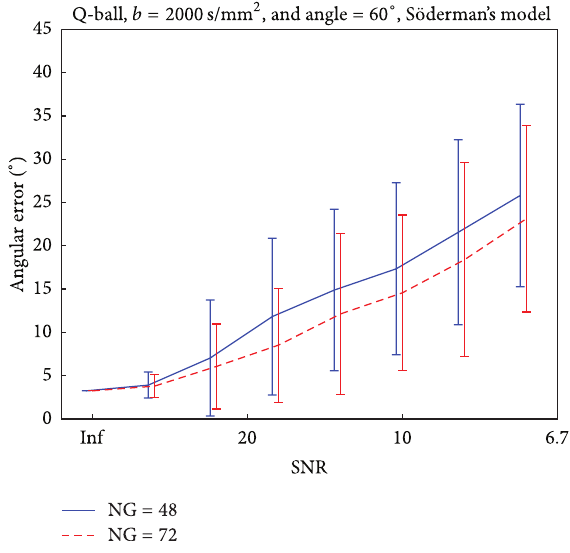
Figure 5: Influence of the SNR on the accuracy of Q-ball imaging for angle of 60 ∘ .